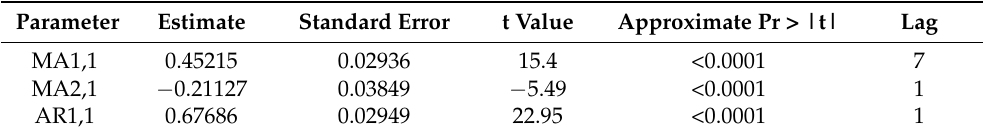
Table 2. Parameter estimation of the seasonal ARIMA(1,1,1)(0,0,1) 7 model to forecast hospital visits due to influenza based on a seven-day average ED visits with fever.